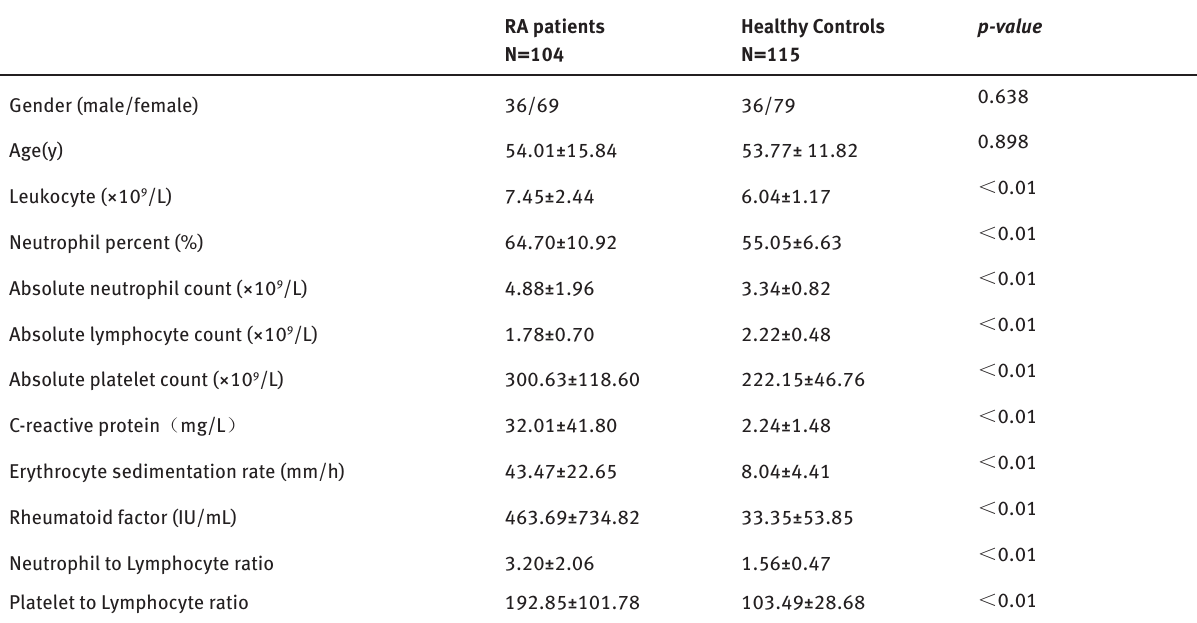
Table 1: Participant characteristics